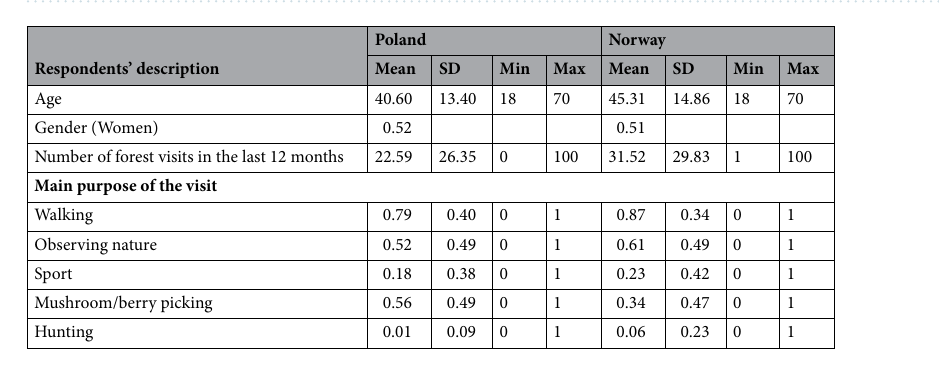
Table 2. Descriptive statistics of respondents from the general public to investigate forest preferences in Poland (N = 1097) and Norway (N = 1005) in 2016.